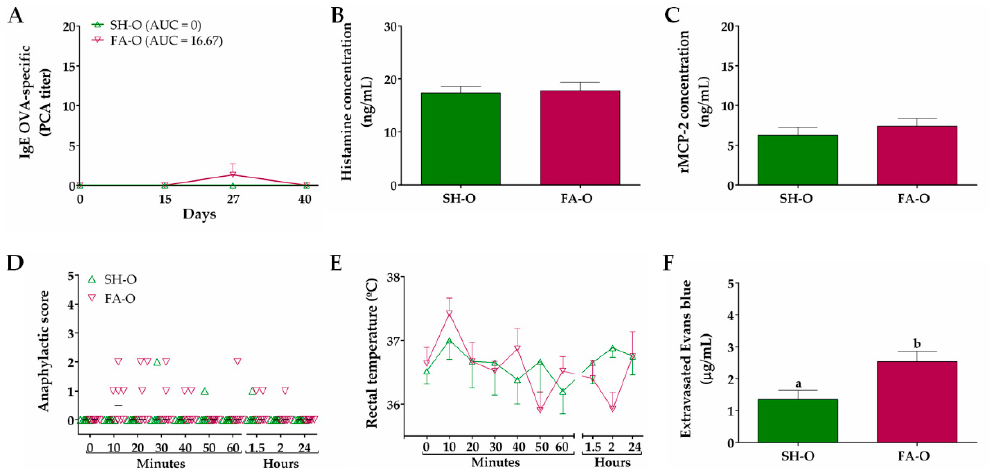
Figure 4. Characteristics of IgE-mediated food allergy (FA) induced by oral allergen sensitization. ( A ) IgE OVA-specific titers in serum at different times measured by passive cutaneous anaphylaxis (PCA) reaction and represented as the inverse of the titer ( n = 6); the values of area under the curve (AUC) were evaluated. Concentration of ( B ) histamine and ( C ) rat mast cell protease (rMCP)-2 in serum 30 and 120 min after OVA challenge at days 27 and 40, respectively ( n = 3). Food anaphylaxis evaluated by ( D ) signs score and ( E ) rectal temperature of animals after the final allergen challenge at day 40 ( n = 6). ( F ) Intestinal edema of rats after the final allergen challenge analyzed by intestinal extravasated Evans blue ( n = 4, in triplicate). SH-O, sham control of oral sensitization and oral challenge; FA-O, FA-induced by oral sensitization and oral challenge. Different letters (a,b) indicate statistical difference. Thus, initial systemic allergen-sensitization using adjuvants is needed in Wistar rats to induce an inflammation in response to oral allergen